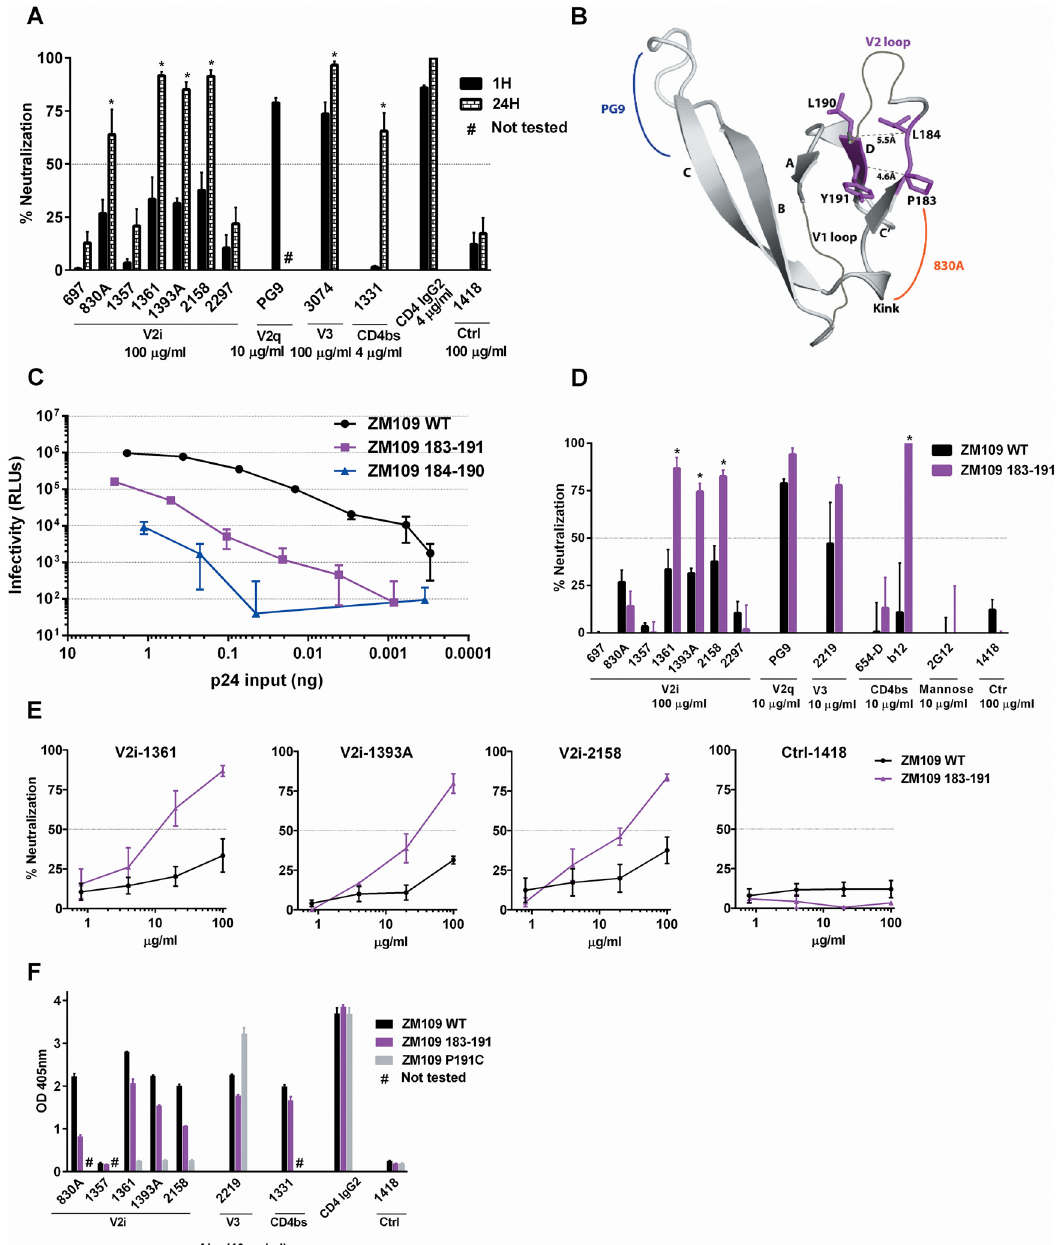
Fig 4. Addition of a disulfide bond to the flexible hypervariable V2 loop of ZM109 significantly increases the virus sensitivity to neutralization by some V2i mAbs. (A) Neutralization of ZM109 WT by V2i and other gp120-specific mAbs following virus-mAb pre-incubation for 1 hour vs. 24 hours. (B) Stabilization of the hypervariable region of V2 loop by a disulfide bond. The two disulfide bonds introduced individually were shown together in this model. The V1V2 region is rendered as ribbons with the mutated residues colored in magenta. The distances of the C atoms of the two pairs are indicated. The epitope locations of 830A and PG9 are indicated by orange and blue curves, respectively. (C) Infectivity of pseudoviruses with WT or mutant ZM109 Envs in TZM-bl cells. (D) Neutralization of ZM109 WT and the disulfide mutant (183 – 191) by V2i and other mAbs. (E) Titration curves showing differences in neutralization sensitivity of ZM109 WT and the 183 – 191 mutant to V2i mAbs 1361, 1393A, and 2158. Statistical analyses were performed for neutralization curves reaching above 50%. * , p < 0.05 based on two way ANOVA test of the mAb titration curves. ( F ) ELISA reactivity of gp120s from ZM109 WT, 183 – 191, and the Y191C single mutant with V2i and other gp120-specific mAbs. CD4-IgG2 and the irrelevant mAb 1418 were also tested as